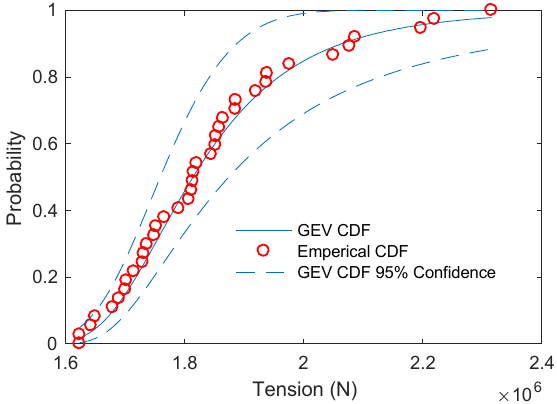
Figure 8. Example Fairlead Tension Cumulative Distribution Function.